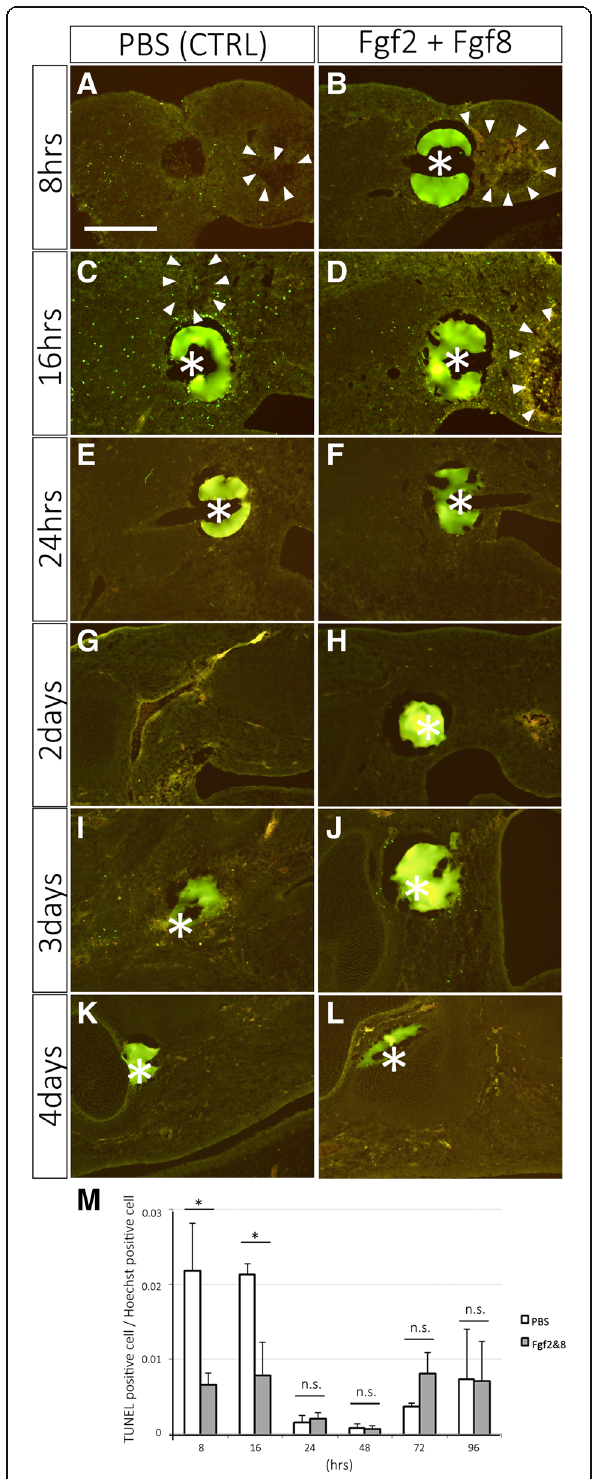
significant difference.* = P <